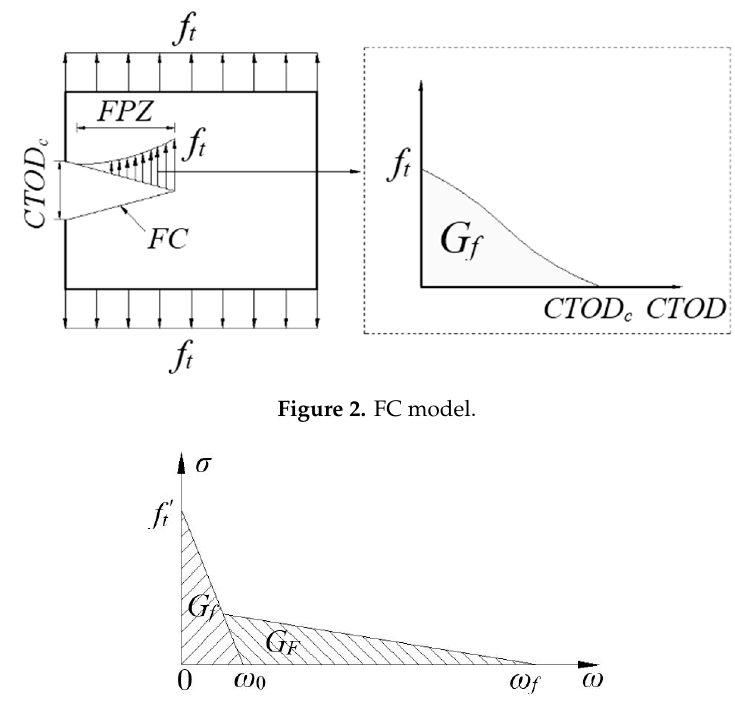
Figure 2. FC model.